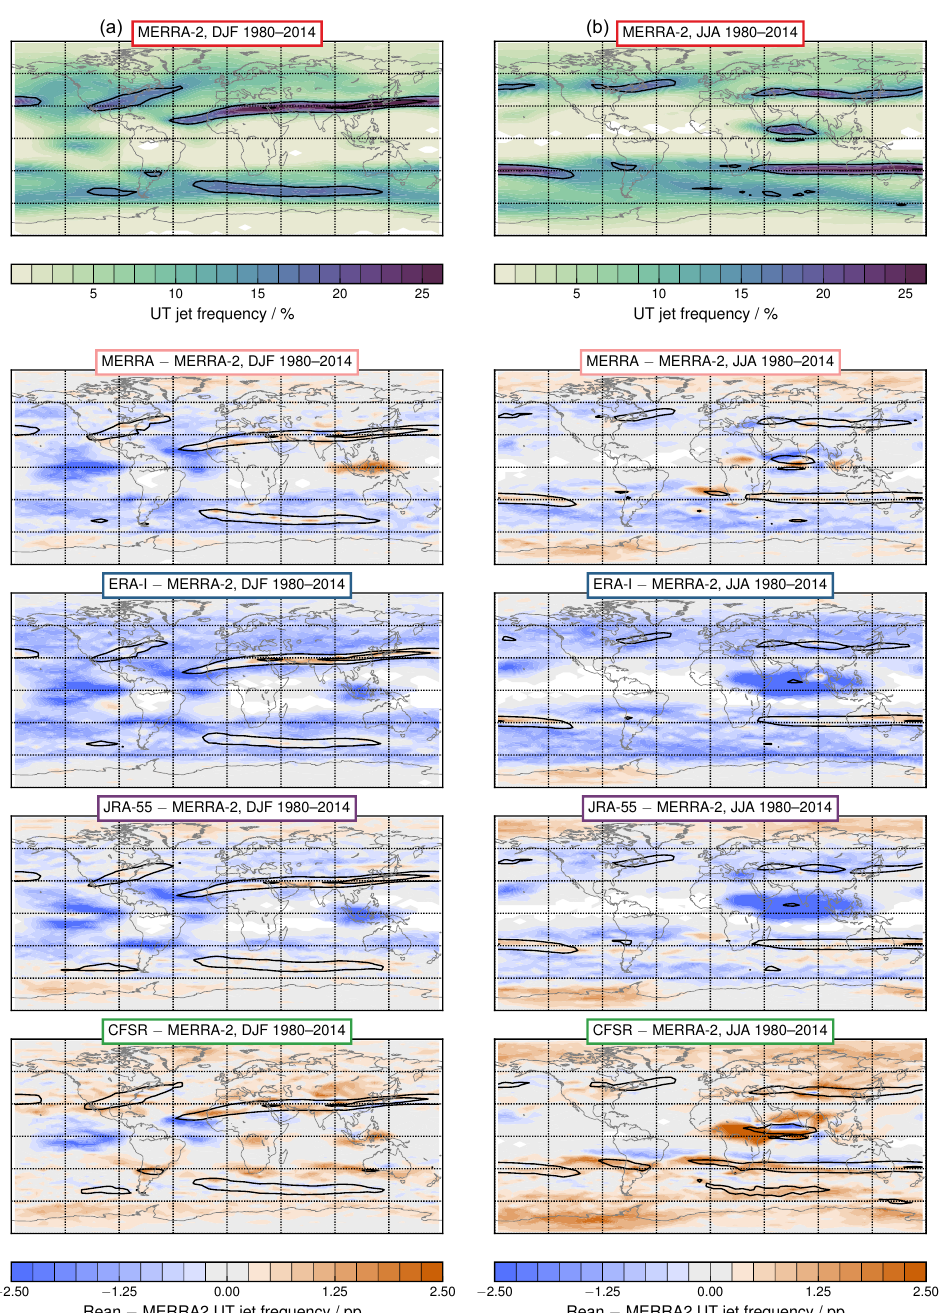
Figure 7. (a) DJF and (b) JJA maps for 1980 through 2014 of MERRA-2 upper tropospheric jet frequency distributions, and differences between MERRA-2 and MERRA, ERA-I, JRA-55, and CFSR. Overlaid contours are climatological frequency distributions for each re- analysis of 15, 30 and 45%; the smallest value is always the largest or “outermost” contour. In the difference plots, blues/oranges indicate negative/positive